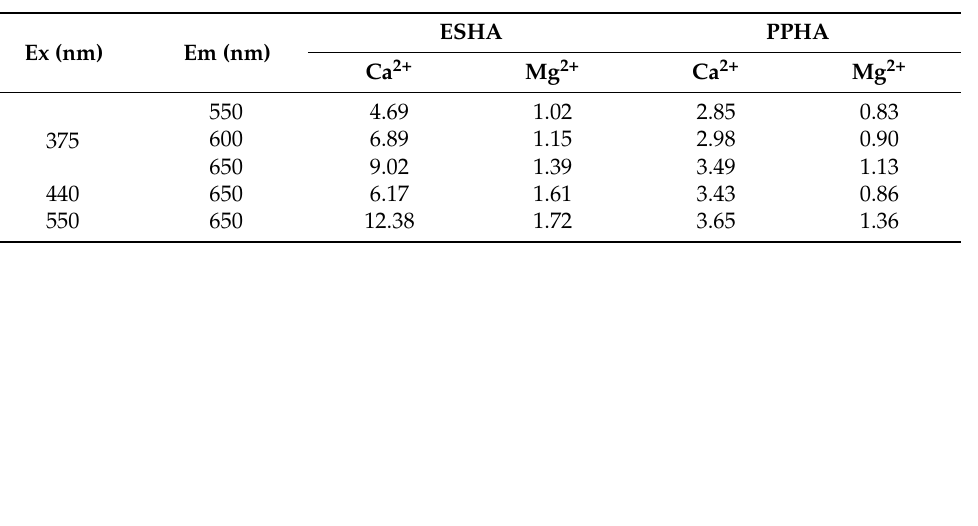
Figure 1. Effects of Mg 2+ and Ca 2+ concentration on the EEM spectra of ESHA (10 mg C/L) aqueous solution. Table 1. Binding constants ( K , 10 4 L/mol) of Ca 2+ and Mg 2+ to ESHA and